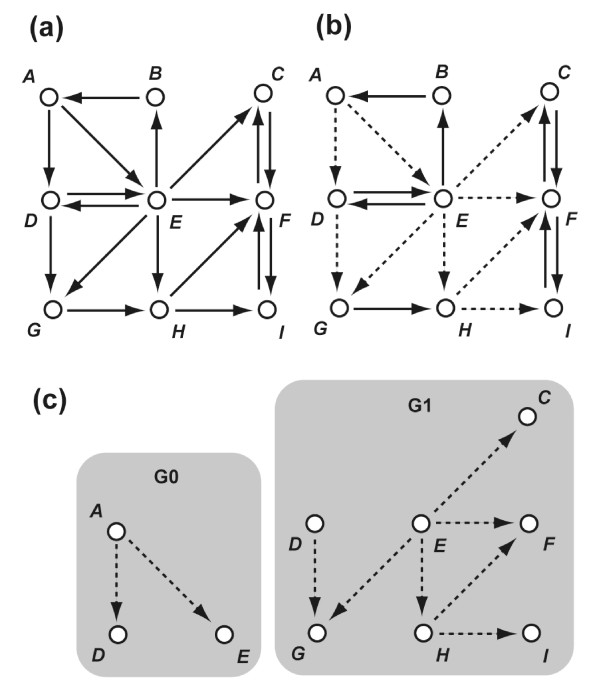
An example of independent groups. (a) Initially deduced edges (Eide). (b) Essential edges (Ees). Uncovered edges in main components () are dotted. (c) Independent groups of uncovered edges in main components. Uncovered edges in main components are separated into two independent groups G0 () and G1 (). Edges in one group do not explain those in other group.  consists of  and .  consists of , , , , and .